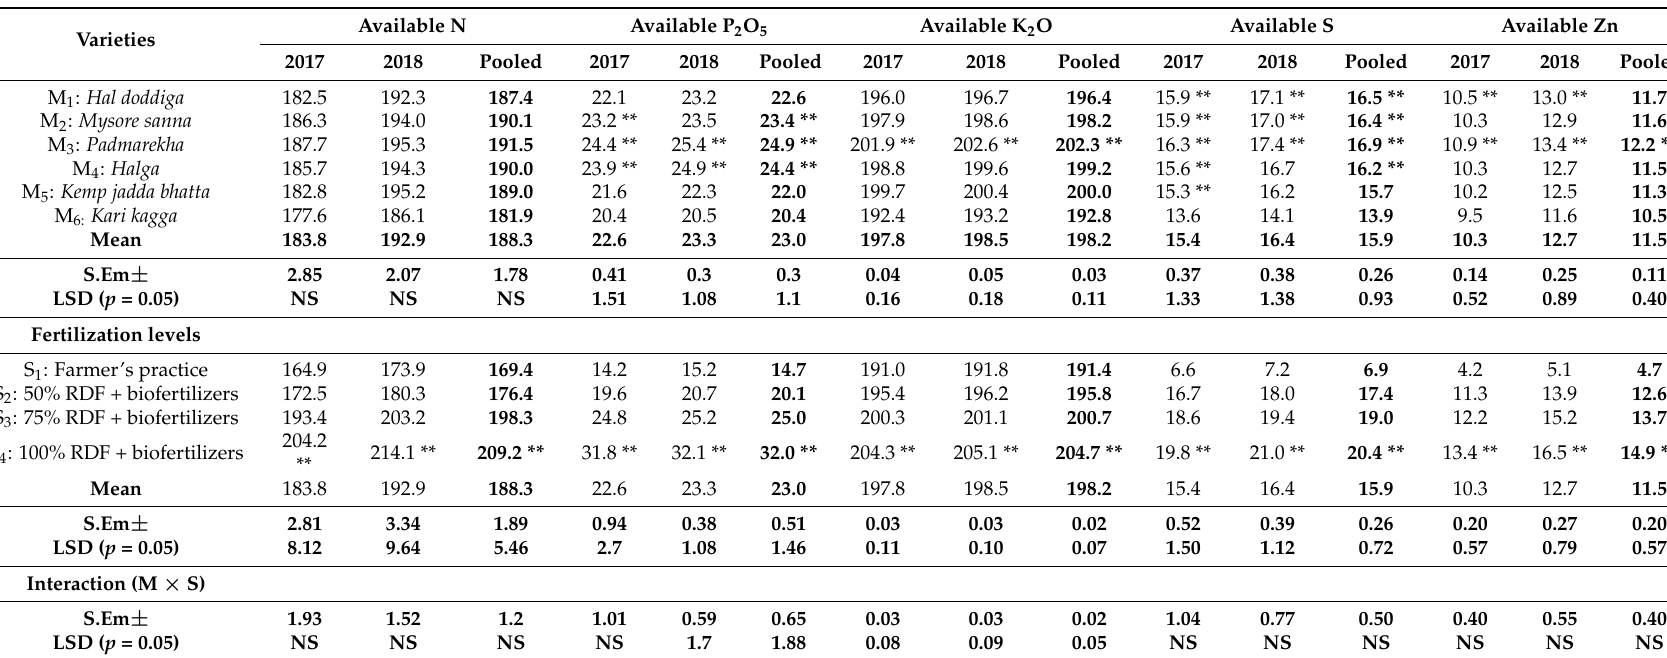
Table 4. Available N, P 2 O 5 , K 2 O (kg ha − 1 ) S and Zn (ppm) after harvest of traditional paddy landraces, as influenced by different fertilizer levels in conjunction